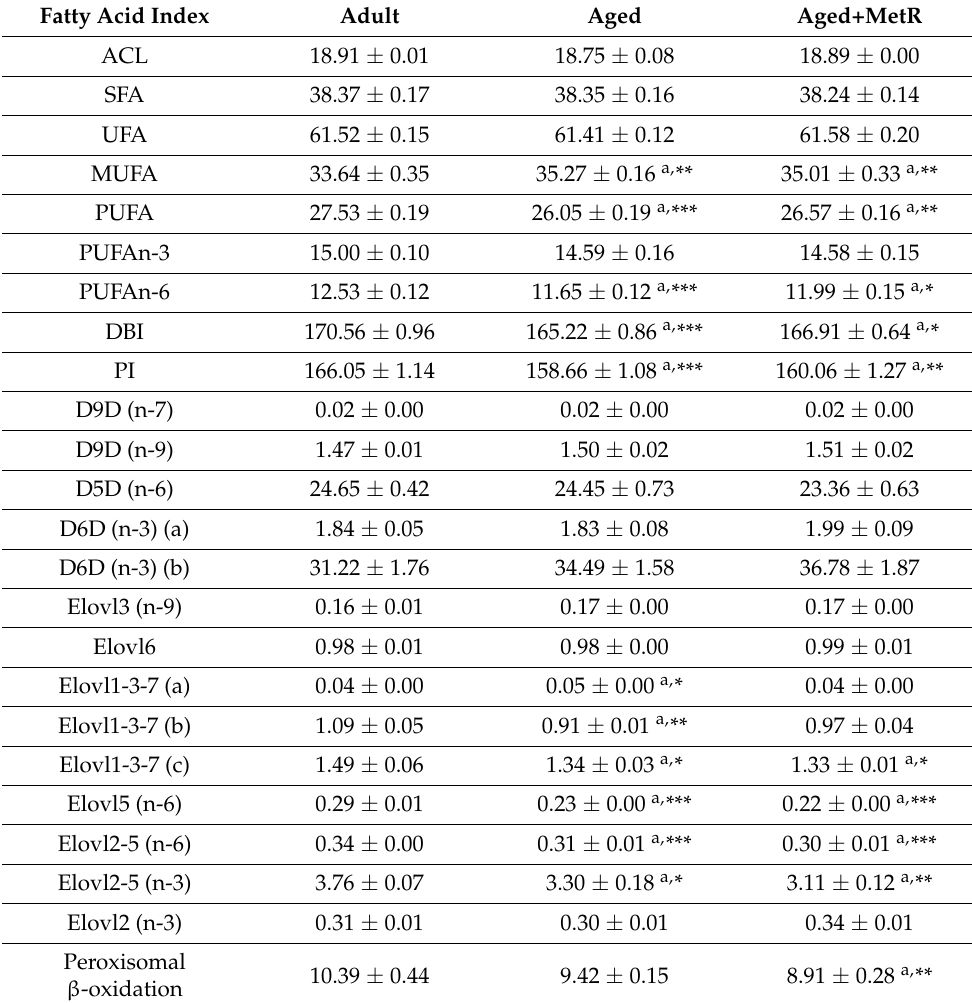
Table 3. Calculated fatty acid indices from the fatty acid profile in the rat